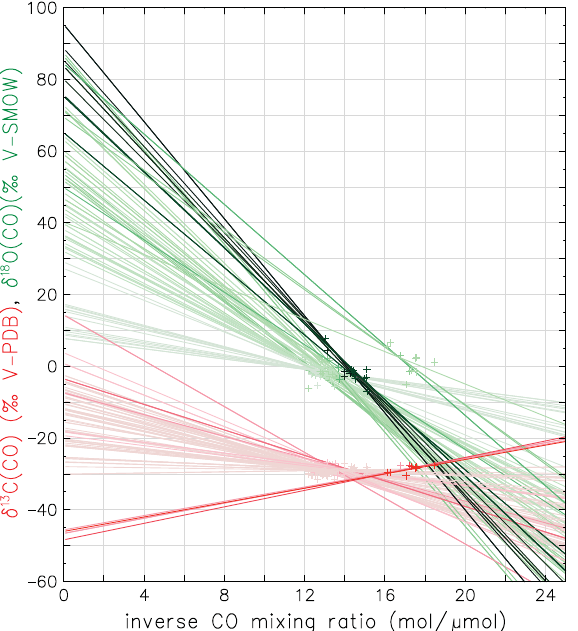
Figure 5. Keeling plot of the data used in the calculations with the mixing model (MM). The C1 WAS isotope CO measurements are shown with symbols, solid lines denote the linear regressions through the various sets of samples selected by the MM ( n = 80 sets are plotted). Colours refer to the δ 13 C (red) and δ 18 O (green) data, colour intensity indicates the coefficient of determination ( R 2 ) of each regression, respectively. Darker colours denote higher R 2 val- ues, with maxima of 0.92 for δ 18 O and 0.54 for δ 13 C data, respec- tively. The inferred contamination signatures δ (CO c ) are found at ([CO]) − 1 → 0. Regression uncertainties are shown in Fig. 6. Note that because different subsets of samples contain same data points, some of the symbols are plotted over (i.e. not all symbols contribut- ing to a particular regression case may be seen).